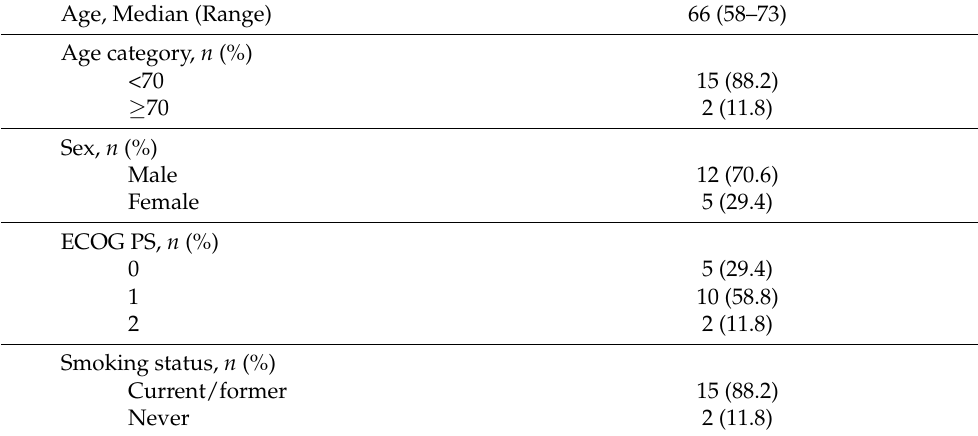
Table 1. Patients’ baseline